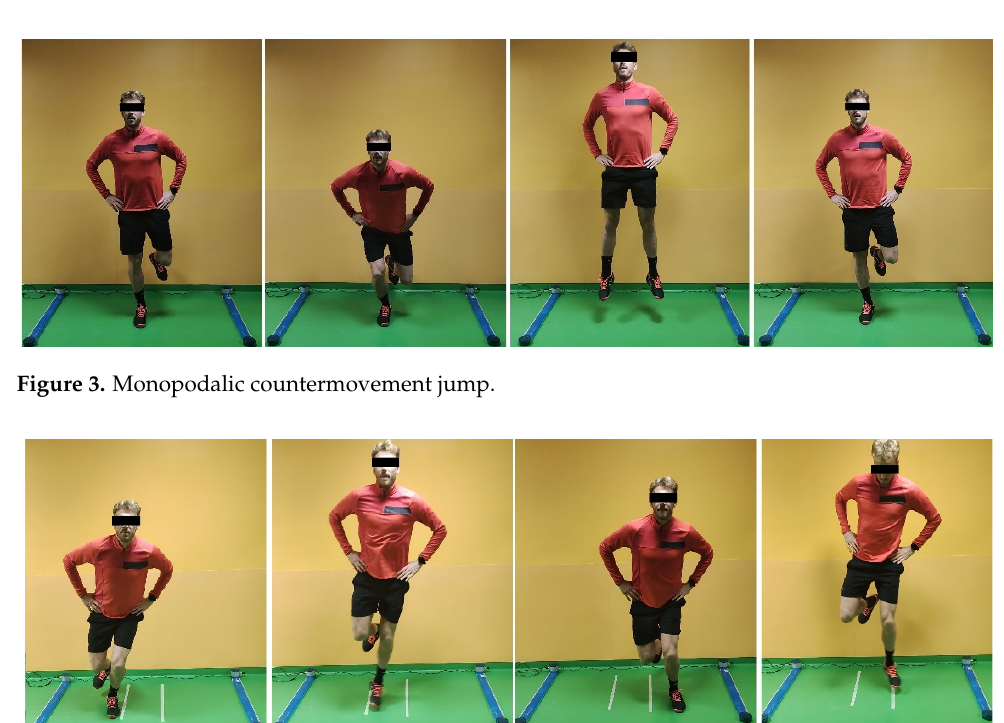
Figure 2. Bipodalic countermovement jump.